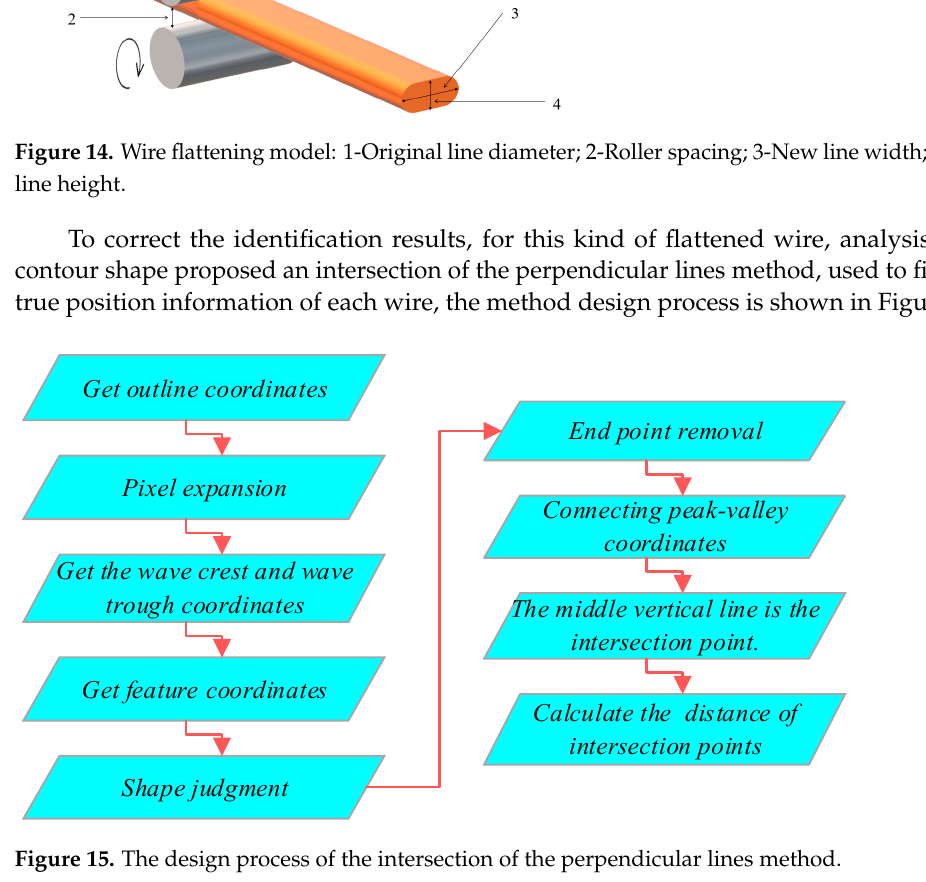
Figure 15. The design process of the intersection of the perpendicular lines method.